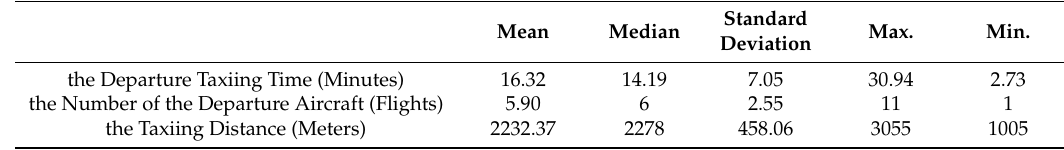
Table 1. Summary of Statistics for the departure flight